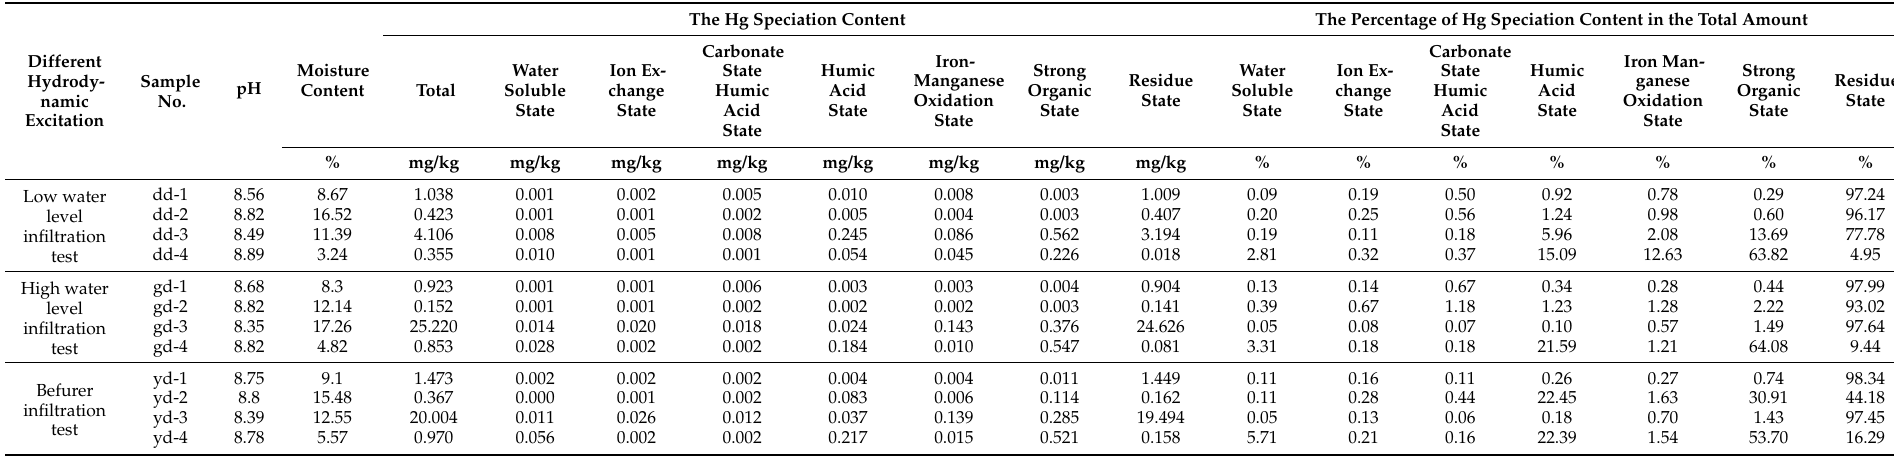
Table 3. List of mercury speciation content and its percentage in subsurface flow zone in the dry